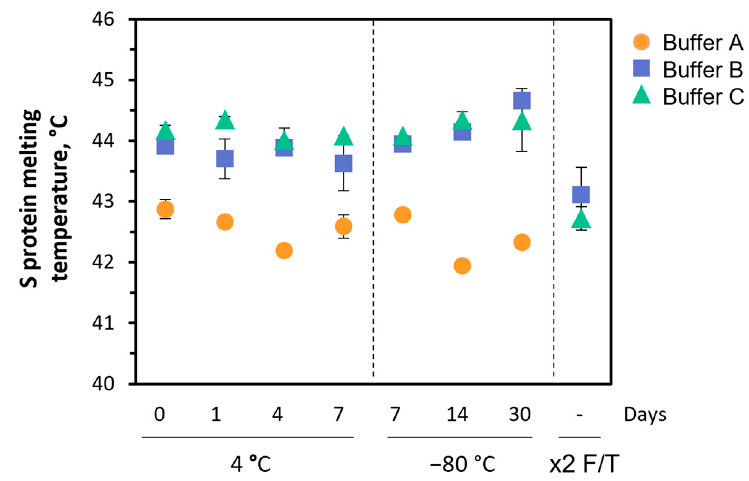
Figure 2. SARS-CoV-2 spike (S) protein thermal stability. Differential scanning fluorimetry analysis of S protein formulated in three different buffers: Buffer A: 10 mM HEPES + 150 mM NaCl at pH 7.2 (orange); Buffer B: 10 mM HEPES + 150 mM NaCl at pH 7.2, 10% glycerol (blue); and Buffer C: 10 mM HEPES + 150 mM NaCl at pH 7.2, 10% sucrose (green). Data are expressed as mean ± standard deviation (relative to three replicates measurements, n =